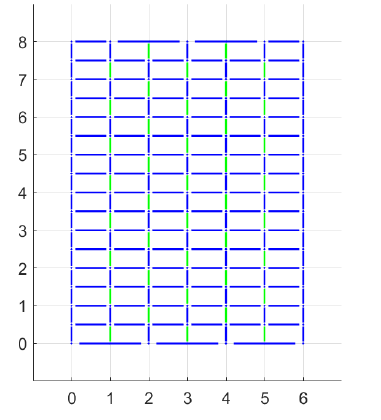
Figure 17. Potential discontinuities assuming non-rigid blocks: blue lines represents discontinu- ities belonging to mortar joints and the green ones discontinuities within the blocks. (Dimensions expressed in units.)